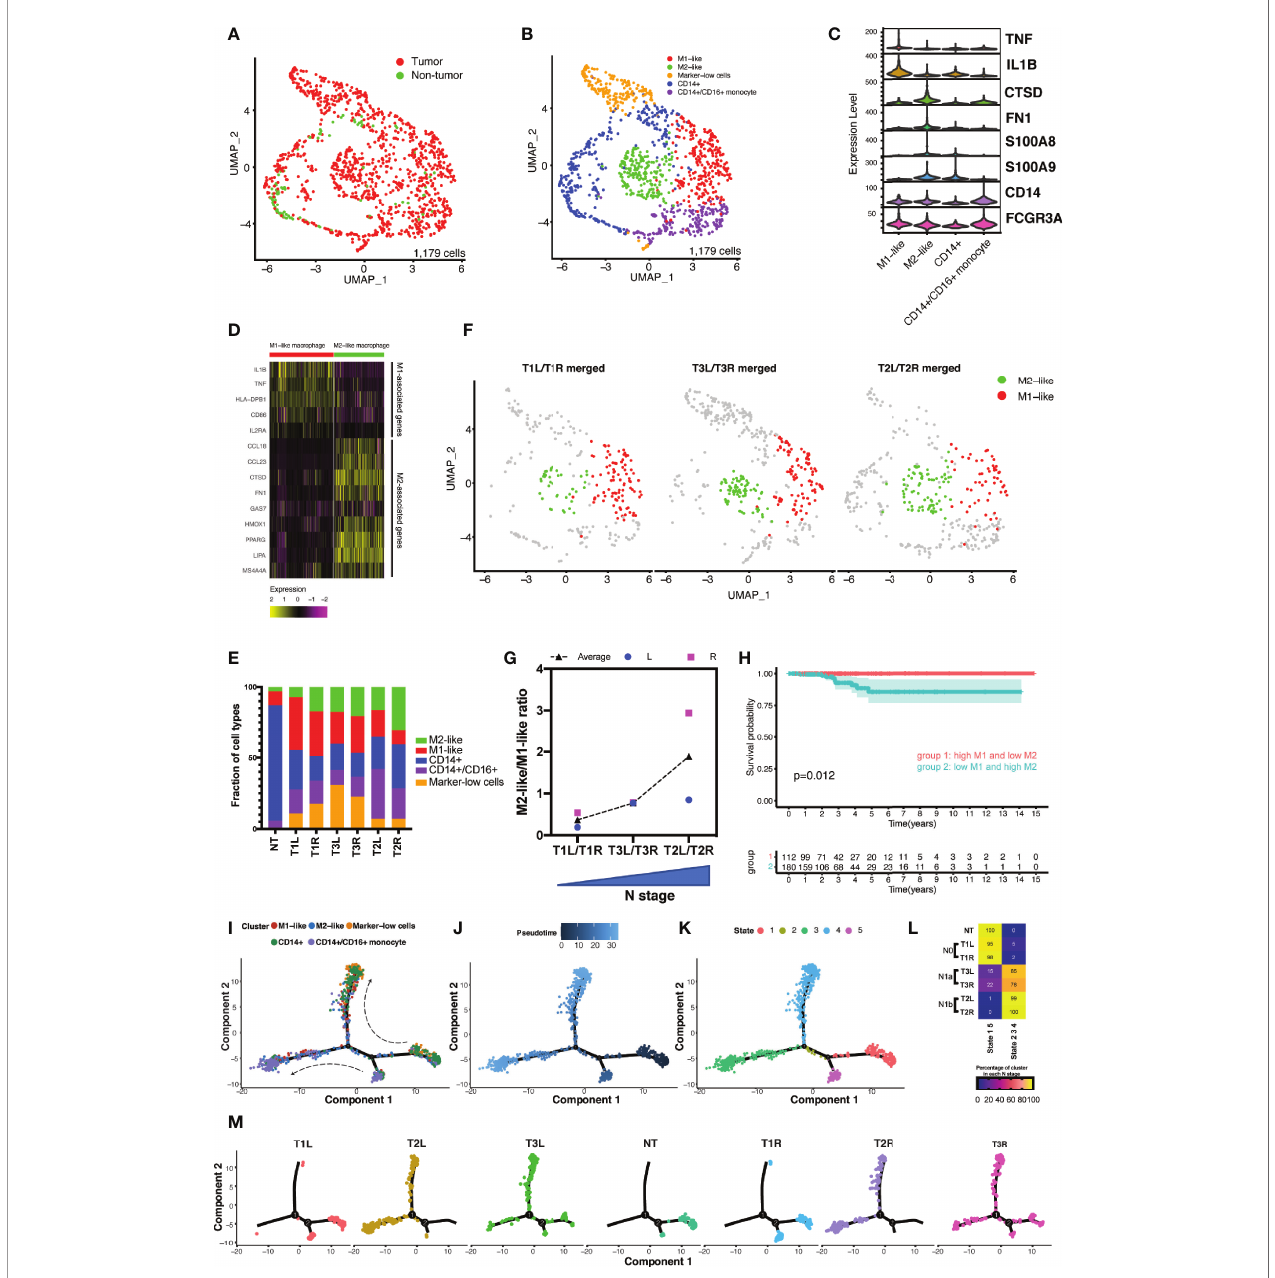
FIGURE 4 | Analysis of the myeloid landscape revealed increased ratio of M2-like/M1-like macrophages in more advanced thyroid cancer. (A) Uniform manifold approximation and projection (UMAP) plot of the classi fi cation of myeloid cells ( n = 1,179) from malignant and non-malignant thyroid tissues. (B) Sub-clustering of myeloid cells ( n = 1,179) identi fi ed CD14 + monocytes ( n = 307), CD14 + /CD16 + monocytes ( n = 205), M1-like macrophages ( n = 257), M2-like macrophages ( n = 200), and marker-low cells ( n = 187). (C) Violin plot showing the expression distributions of canonical marker genes in four cell lineages. (D) M1-like and M2-like signature genes differentially expressed in M1-like and M2-like macrophages. (E) Fractions of cell types of myeloid cells in different thyroid samples. (F) M1-like and M2-like cells highlighted in the UMAP plot of the merged bilateral samples from the same patient. (G) Increased ratio of M2-like/M1-like macrophage was associated with the increased stage of local lymph node metastasis. (H) Kaplan – Meier curve of the overall survival of patients from The Cancer Genome Atlas (TCGA) papillary thyroid carcinoma (PTC) cohort grouped by levels of M1-like and M2-like macrophages. (I – K) Developmental trajectories of myeloid cells displayed by clusters (I) and ordered by pseudotime (J) and states (K) . (L) Association of the proportions of myeloid cells in different trajectory states with disease stage. N0 , no lymph node metastasis; N1a , with central lymph node metastasis; N1b , with lateral lymph node metastasis. (M) Developmental trajectory of myeloid cells in each